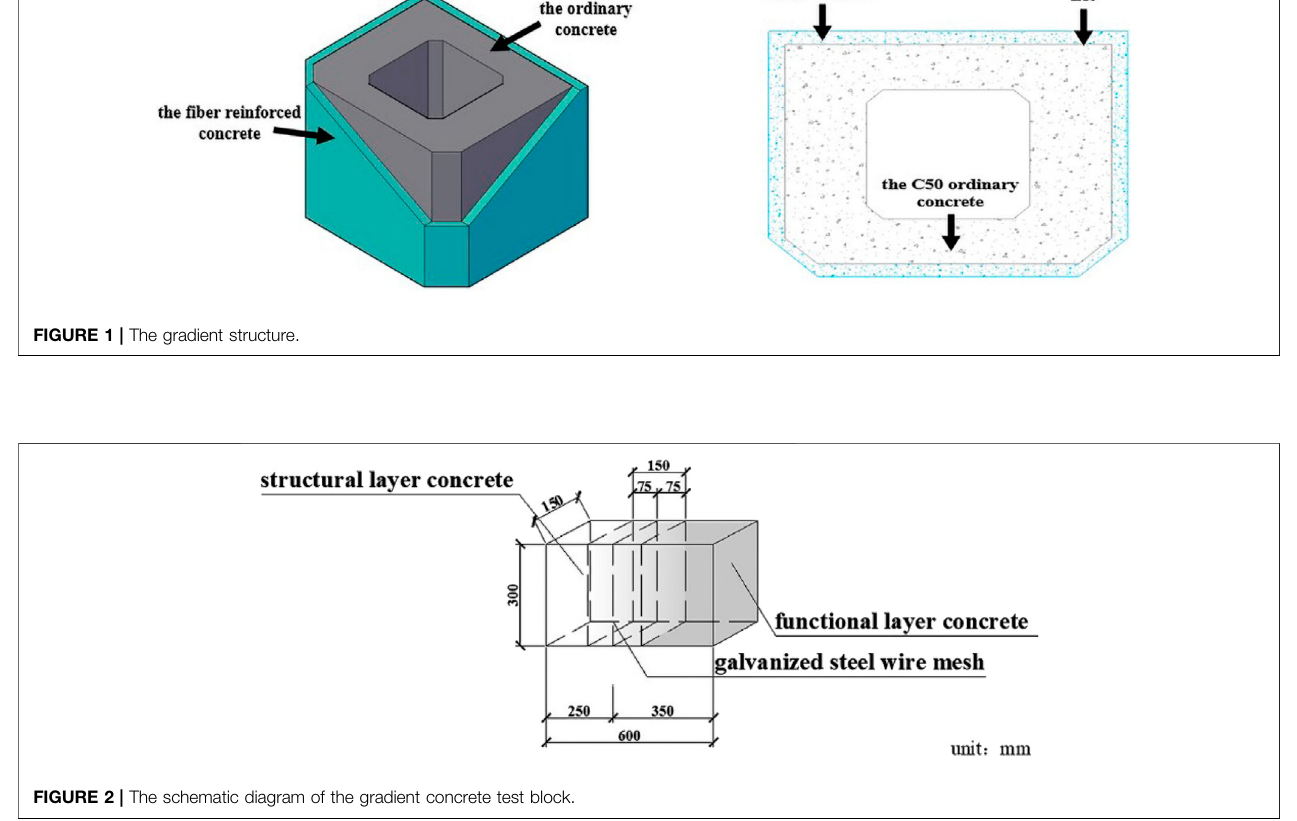
FIGURE 2 | The schematic diagram of the gradient concrete test block.